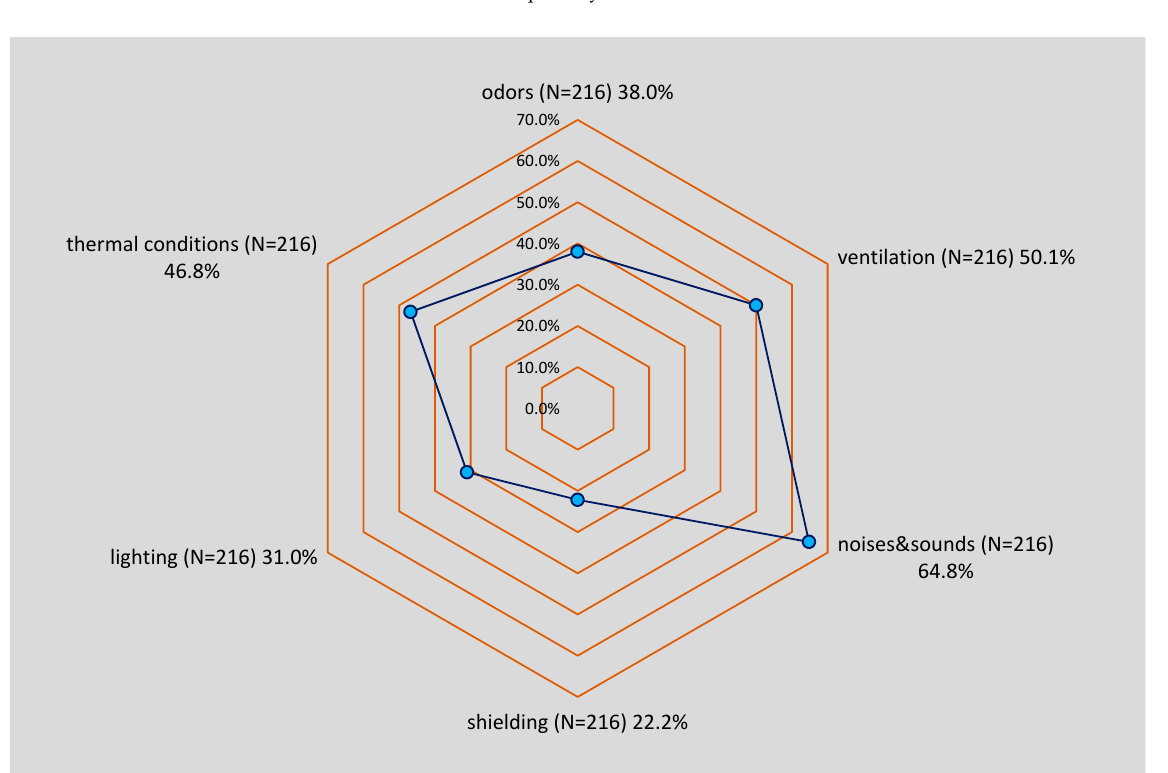
Figure 1. The number of respondents who were dissatisfied with the adjustability of certain IEQ parameters ( N = 216).